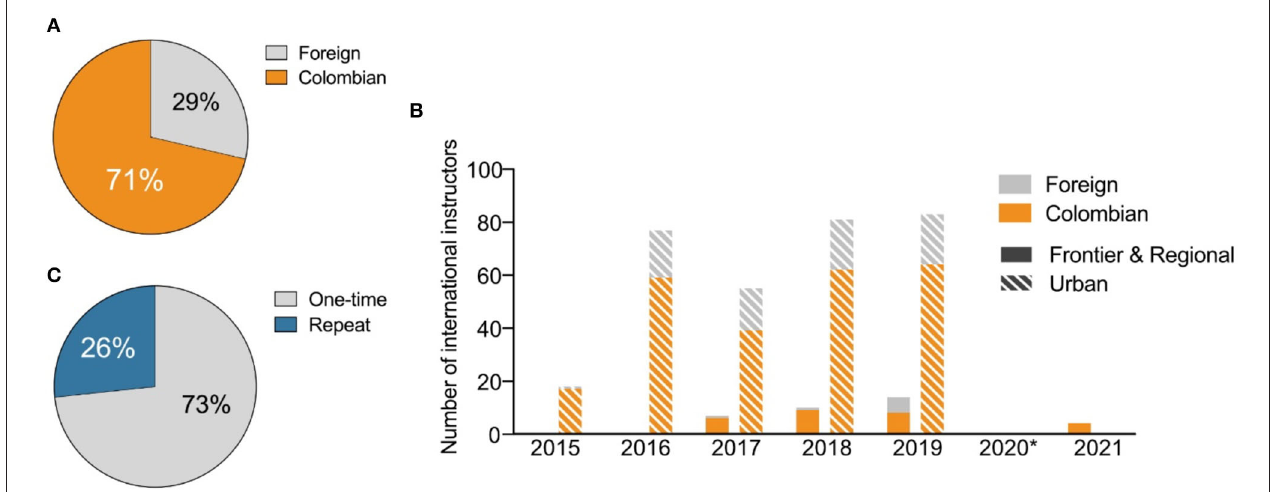
FIGURE 4 | Engagement of the Colombian diaspora. (A) Percentage of international instructors that are Colombian citizens vs. citizens of other countries (“foreign”). (B) Visualization of the proportion of international instructors involved in Frontier, Regional, and Urban versions of SCC who are Colombian citizens vs. foreign. (C) Percentage of international instructors who have participated in the Program for multiple